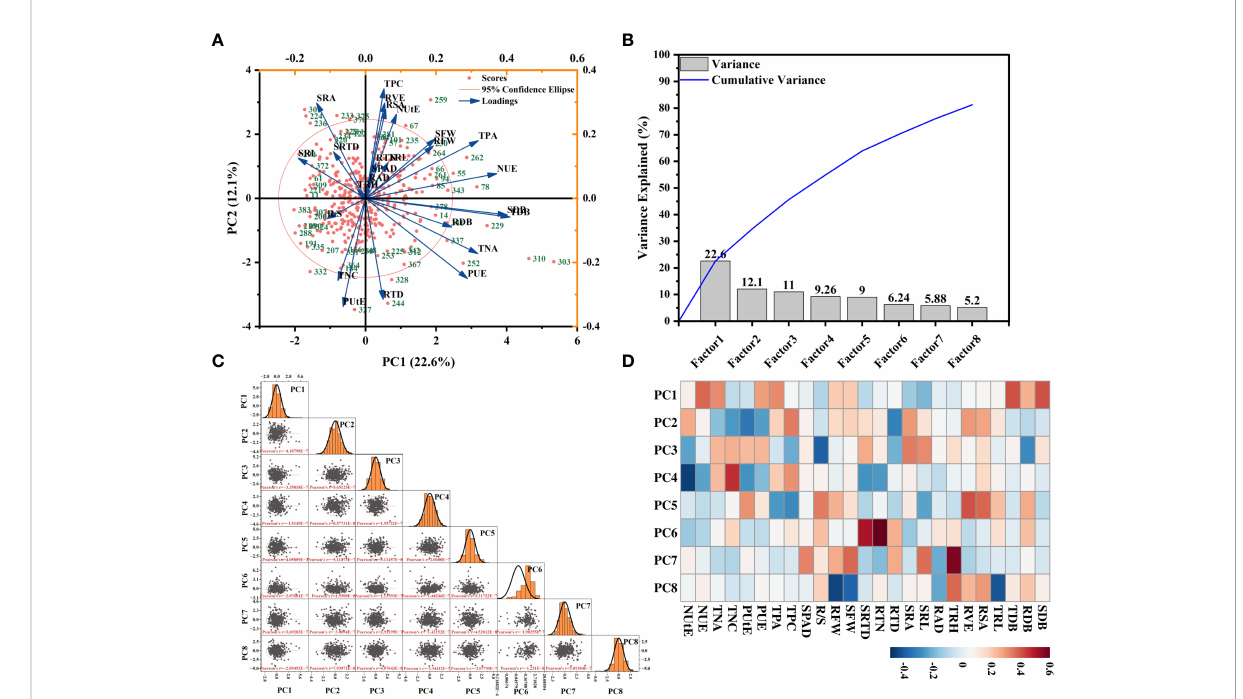
FIGURE 9 Principal component analysis (PCA) of morphological traits of 384 cotton genotypes in response to changes in each trait ’ s relative values. The fi rst two principal components of scores (A) are indicated. The position of each genotype in the principal component space is indicated by a red circle, (B) a factor variance plot, (C) and score matrix of genotypes, and (D) principle factors heatmap. Genotype names are replaced with numbers, and the genotypes represented by each number correspond to those described in Supplementary Table 1. Points are the mean values with replicates per